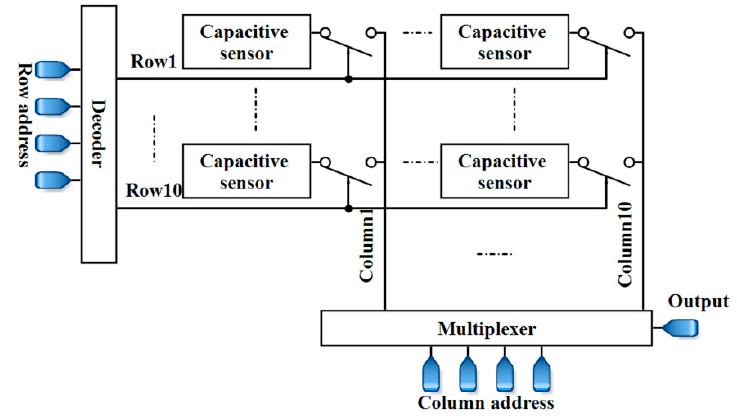
Figure 24. A 10 × 10 array of the proposed capacitive sensor.